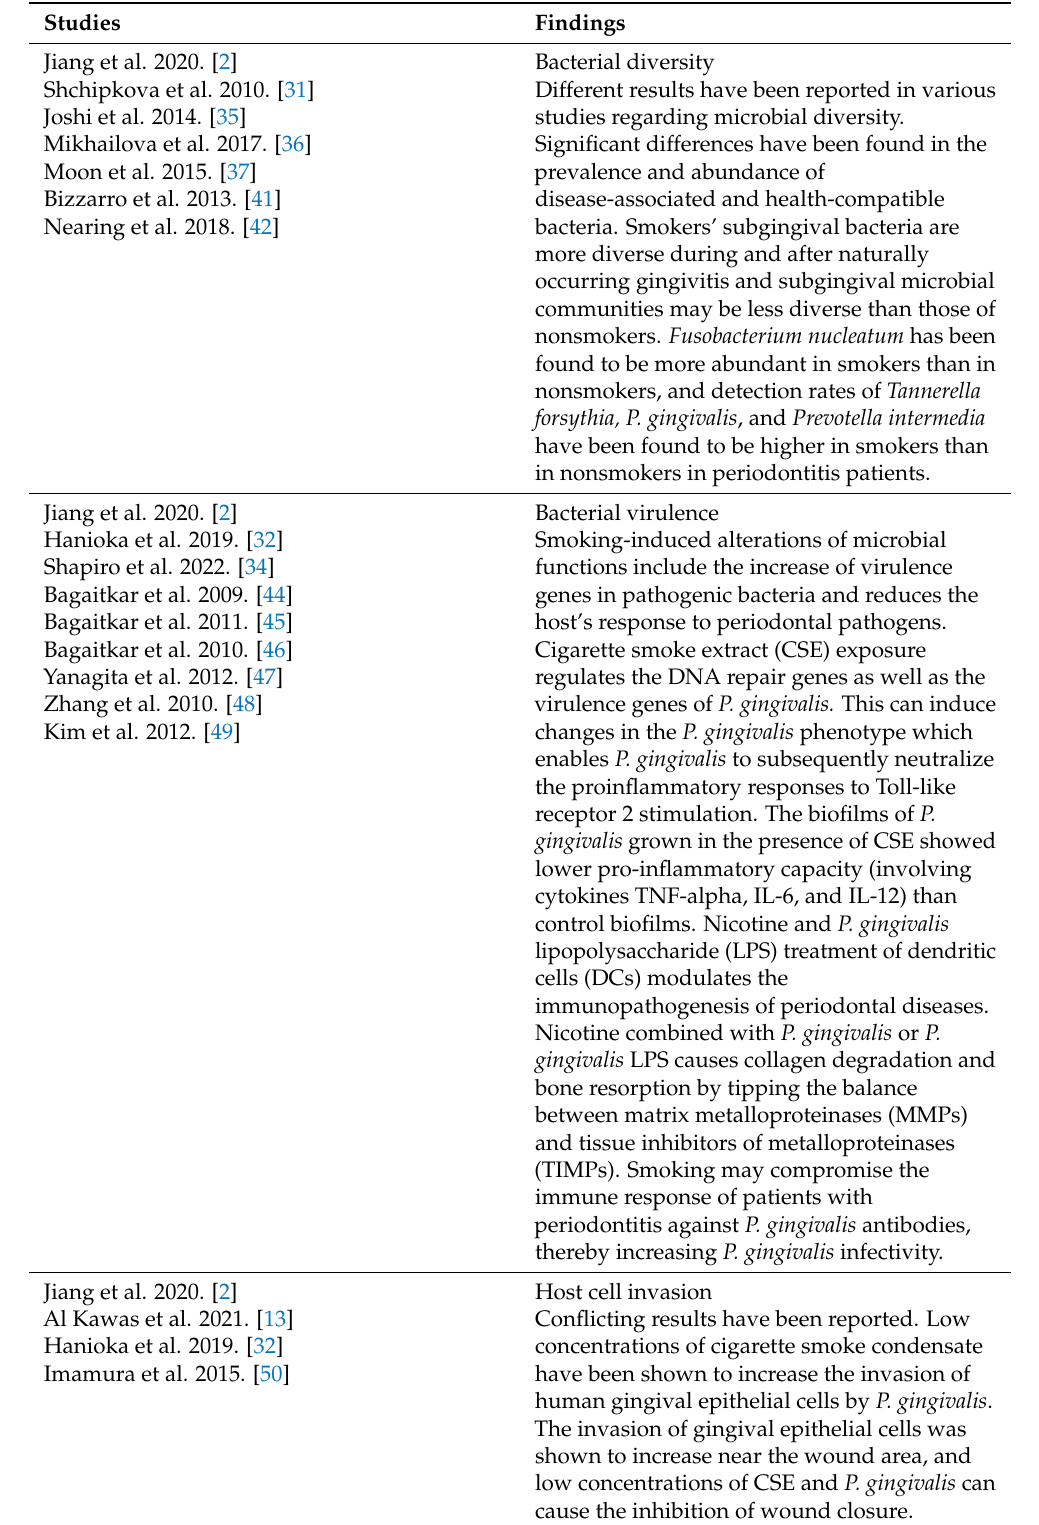
Table 1. Smoking and the periodontal